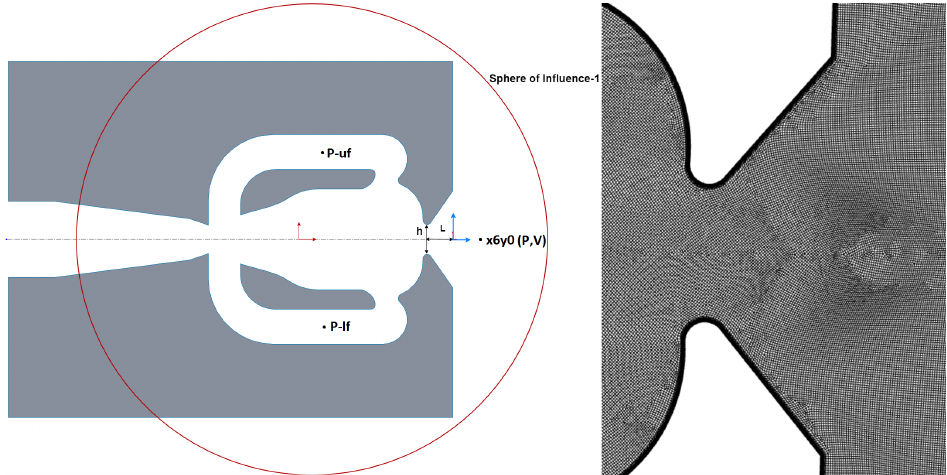
Figure 3. ( Left ) SWJA geometry showing the position of different sampling points, uf, lf, and x6y0, exit nozzle height, h, exit nozzle length, l, with global coordinates (blue arrow), and Sphere of Influence 1 (red circle) used for focused meshing. ( Right ) Close view of the mesh near the exit nozzle